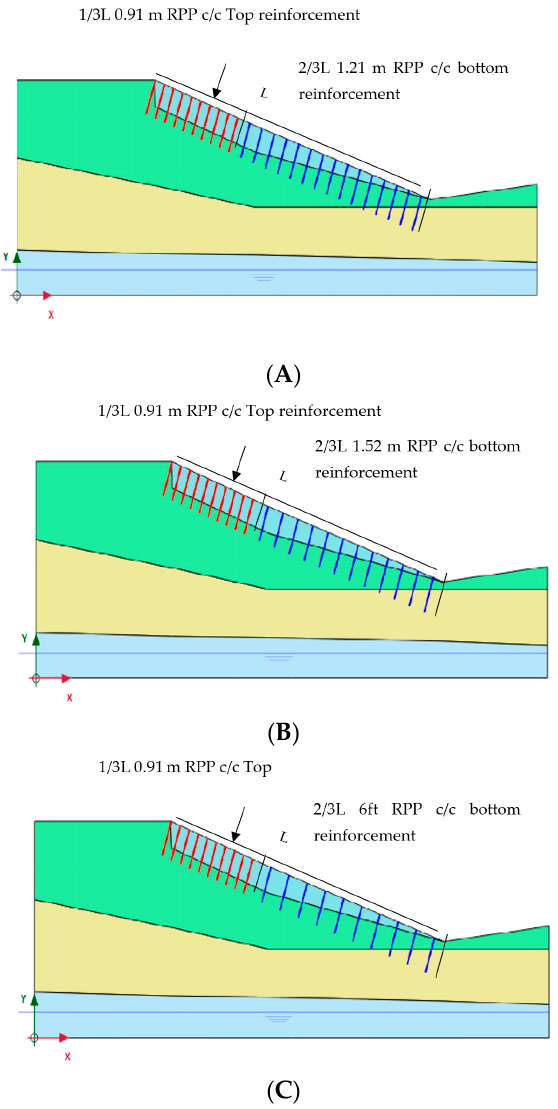
Figure 4. RPPs layout at the top and bottom part of the slope: ( A ) configuration D, ( B ) configuration E, and ( C ) configuration F. Table 2. Numerical modeling matrix.